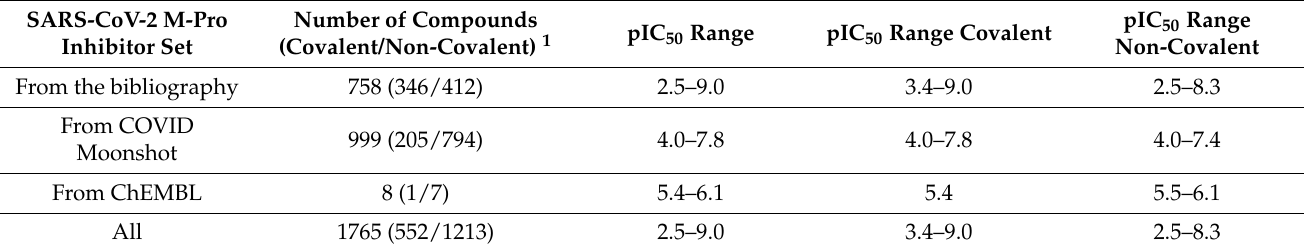
Table 1. Number of SARS-CoV-2 M-pro inhibitors collected.